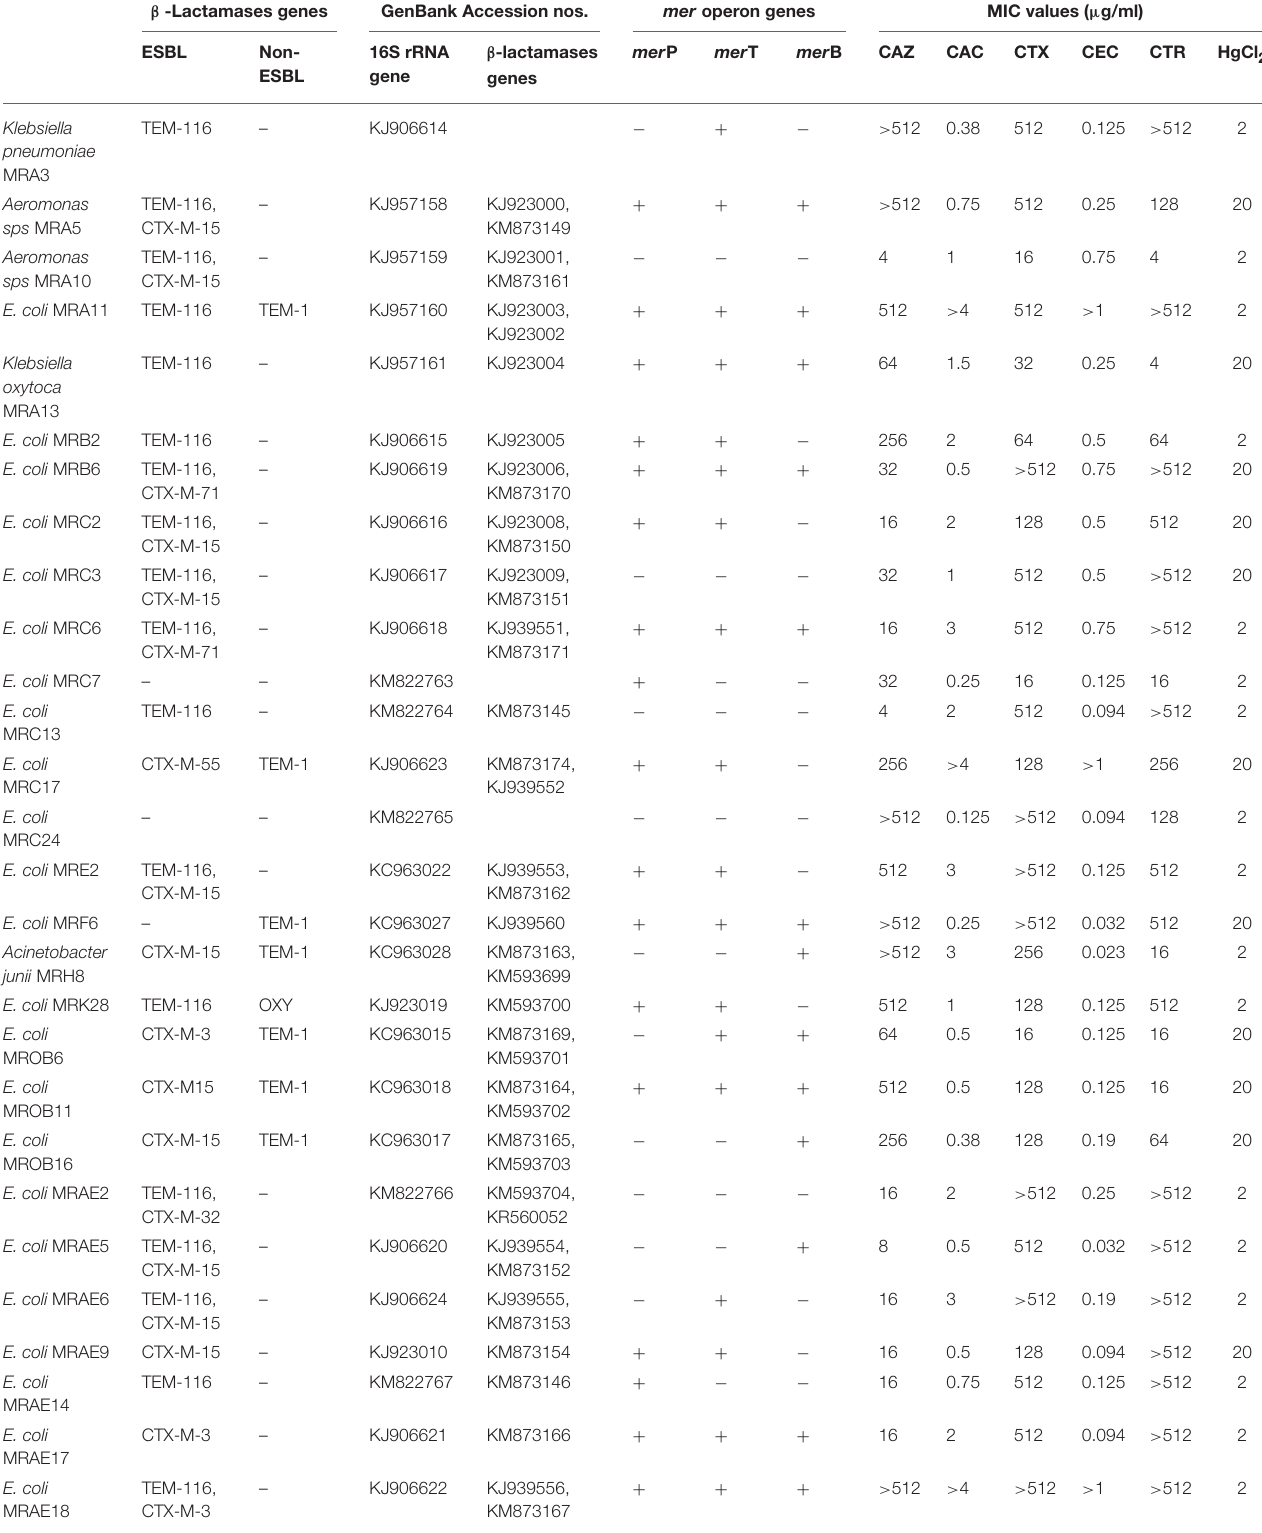
TABLE 2 | Characterization of gene sequences along with their MIC values for different antibiotics and heavy metals among ESBL + bacterial isolates. β -Lactamases